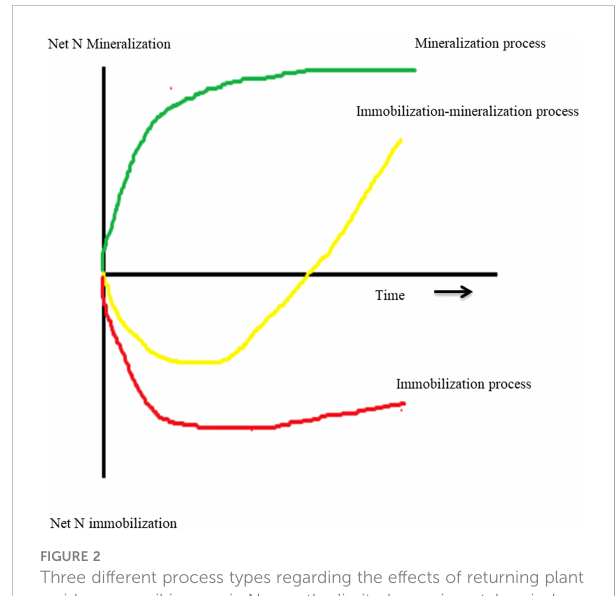
FIGURE 2 Three different process types regarding the effects of returning plant residues on soil inorganic N over the limited experimental period (Chen et al.,